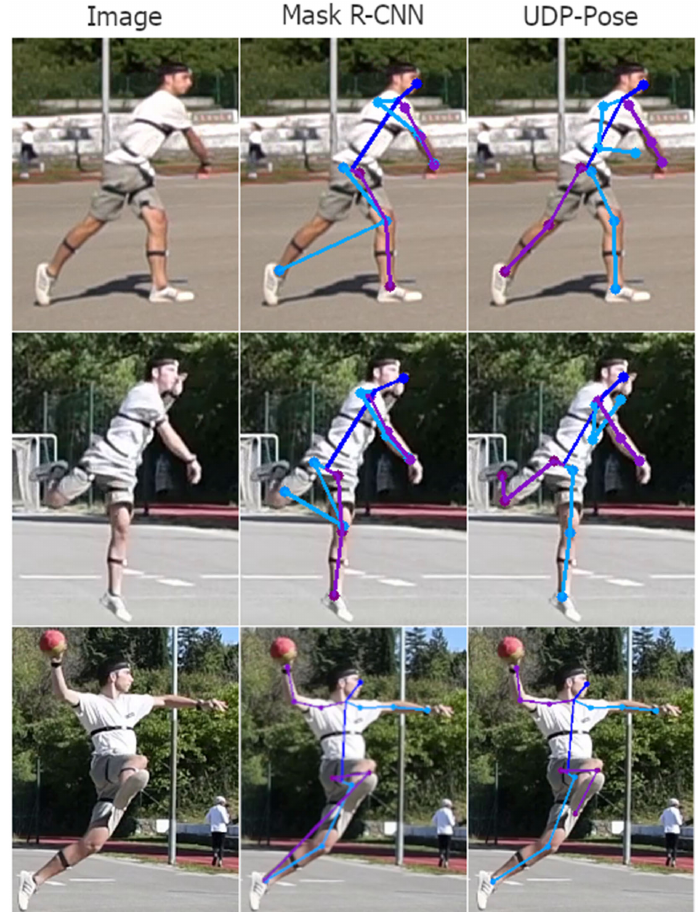
Figure 21. Examples of detection after training on the 227 images of the RI-HJS dataset. The right side of the player is coloured purple while the left side of the person is coloured blue. Untrained models missed detection when the left hand was hidden or less clear, as shown in Figure 18. After training, UDP-Pose successfully detected the left hand on the second row, while on the first row, it made a reasonable guess of the hand position. Mask R-CNN performed worse on both examples after training, wrongly detecting the right knee location on the left knee.